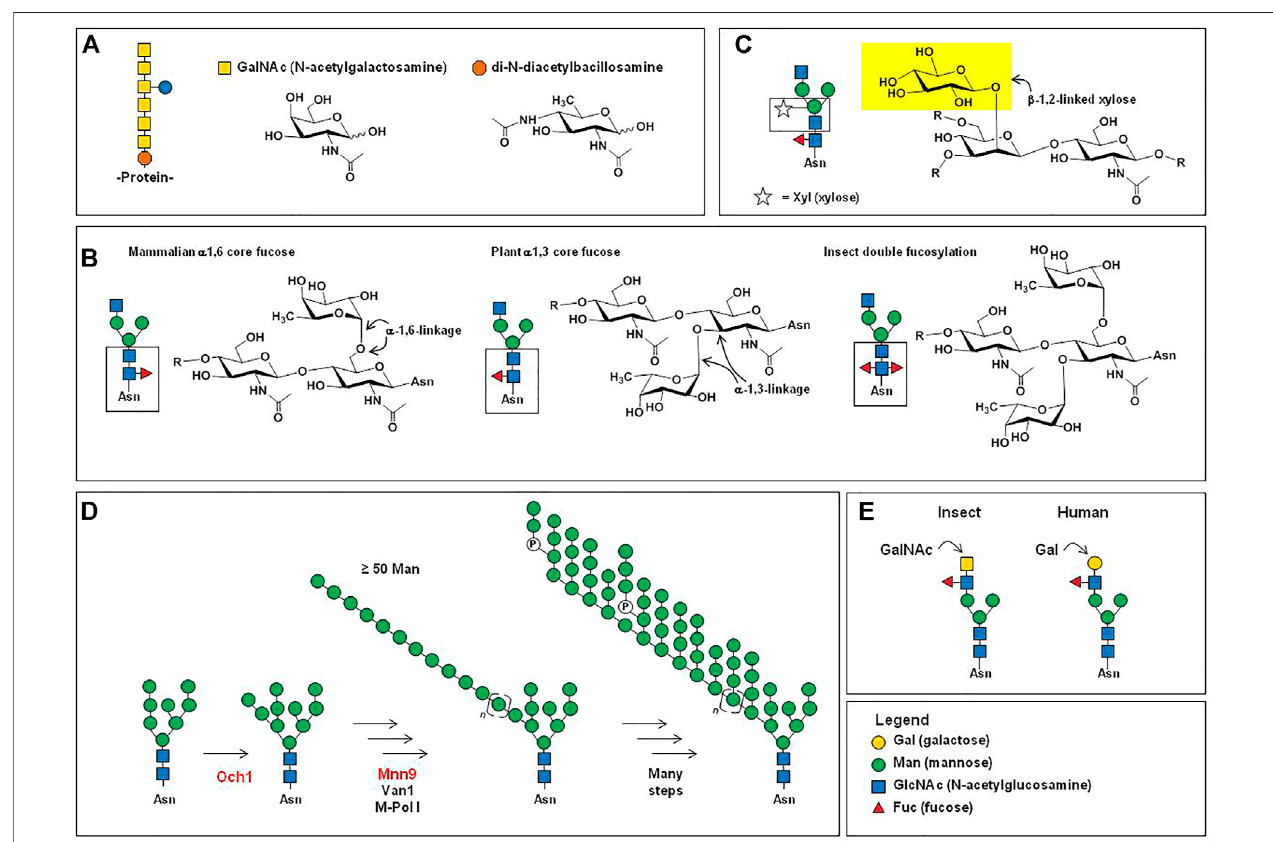
FIGURE7| Glycoformsofconcerninbacterial,plant,fungal,andinsectproductionsystems. (A) Effortstoproduceglycosylatedrecombinationproteinsinbacteria ( Section 5.3.3 ) have resulted in the non-human glycan structure shown. (B) Mammalian N-glycans have α 1,6-linked core fucose (right), which along with sialic acid, endow IgG antibodies with anti-in fl ammatory properties; plant cells ( Section 5.3.4 ) produce N-glycan with α 1,6-core fucose (center), and insect cells ( Section 5.3.6 ) produce doubly-fucosylated N-glycans (right). (C) Xylose, a monosaccharide not present in mammalian N-glycans, is added to plant-produced N-glycans ( Section 5.3.4 ). (D) Mannan synthesis in fungi ( Section 5.3.5 ). (E) GalNAc incorporation in insects as compared to human galactose addition ( Section 5.3.6